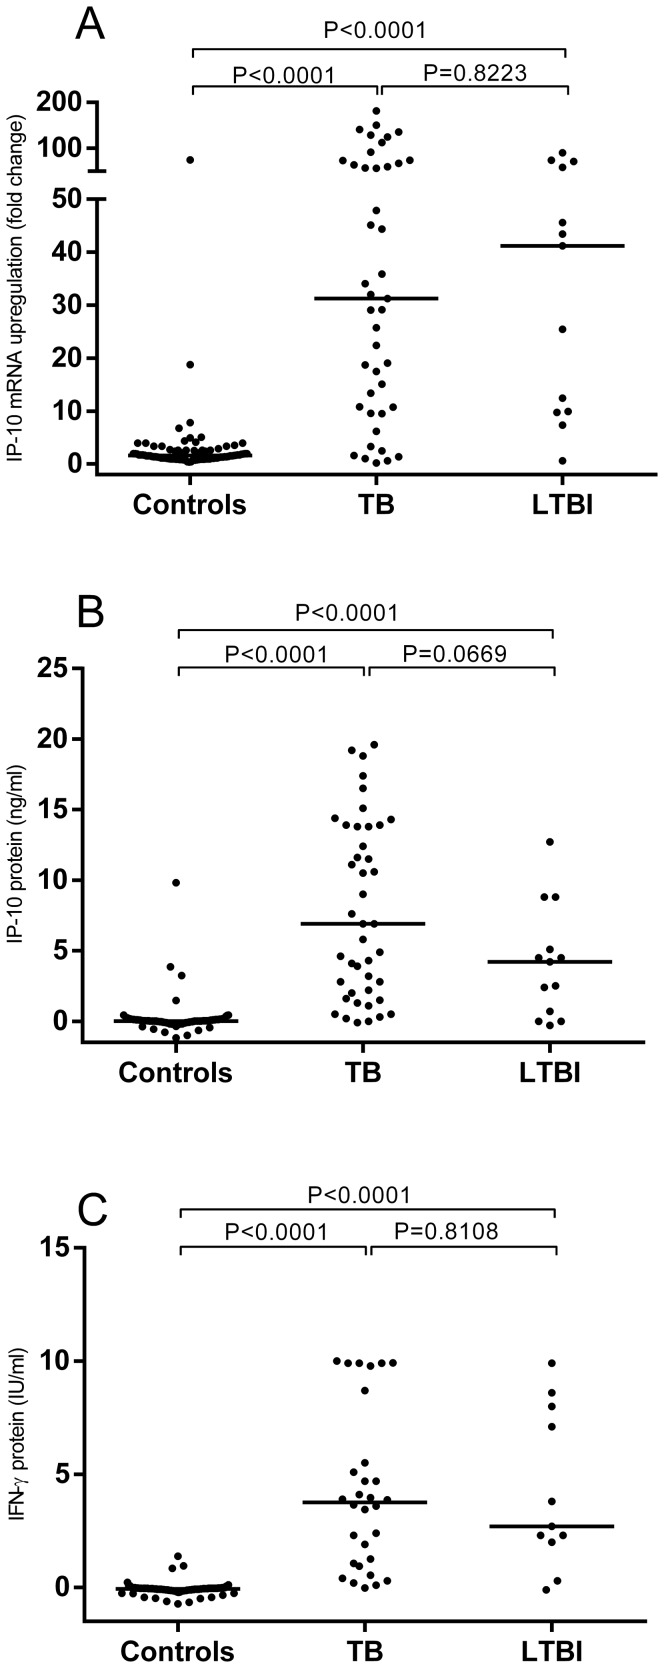
IP-10 mRNA expression and IP-10 and IFN-γ protein release.Whole blood from 96 healthy controls, 43 TB patients and 13 LTBI persons was stimulated with ESAT-6, CFP-10 and TB7.7. IP-10 gene expression was analysed from DBS after 8 hours stimulation (A) and IP-10 and IFN-γ protein levels were analysed from plasma after 20 hours stimulation (B and C respectively). A Kruskal Wallis test was performed to analyse the differences between the groups. IFN-γ mRNA gene expression was not measured in this experiment.